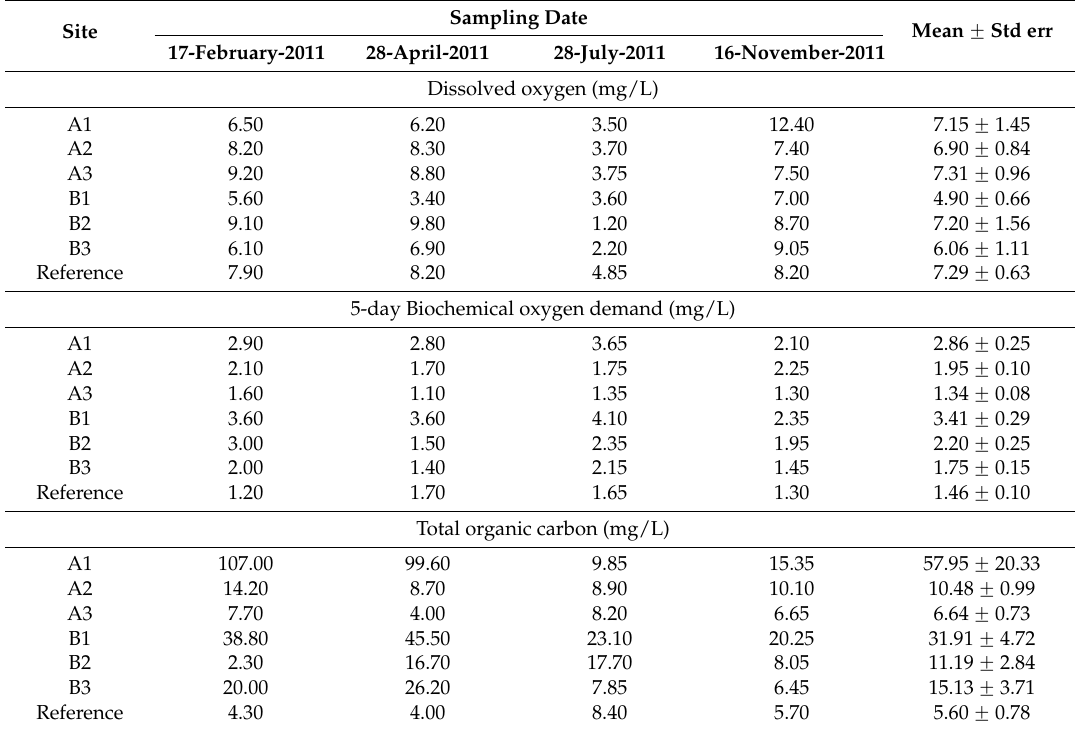
Table 2. Surface water dissolved oxygen, total organic carbon, and 5-day biochemical oxygen demand measured at sampling sites in the CWU.